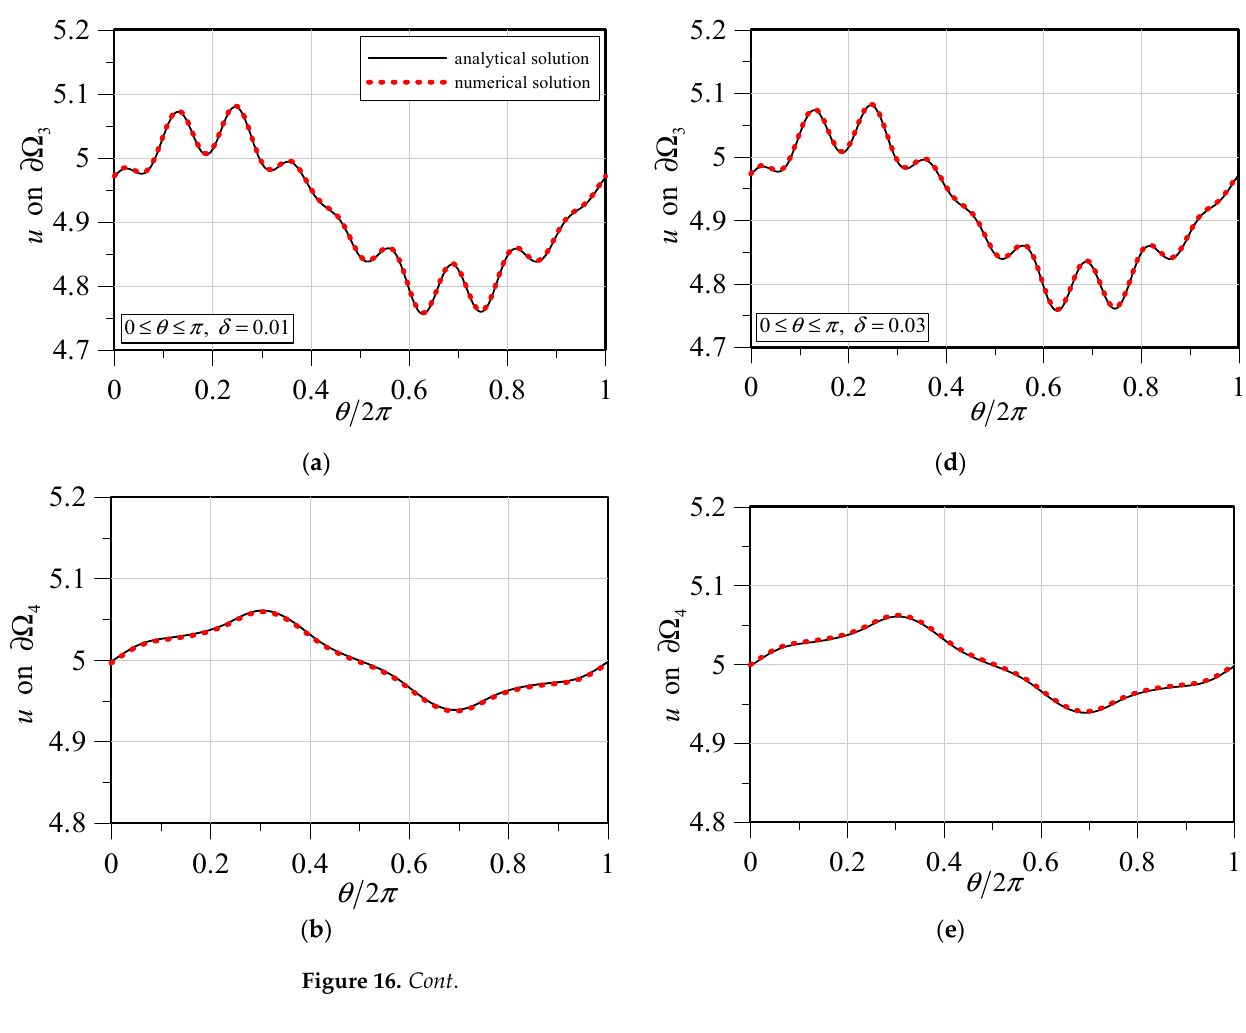
Appl. Sci. 2022 , 12 , x FOR PEER REVIEW Figure 15. Comparison of the results for Example 2. Figure 15. Comparison of the results for Example 2.